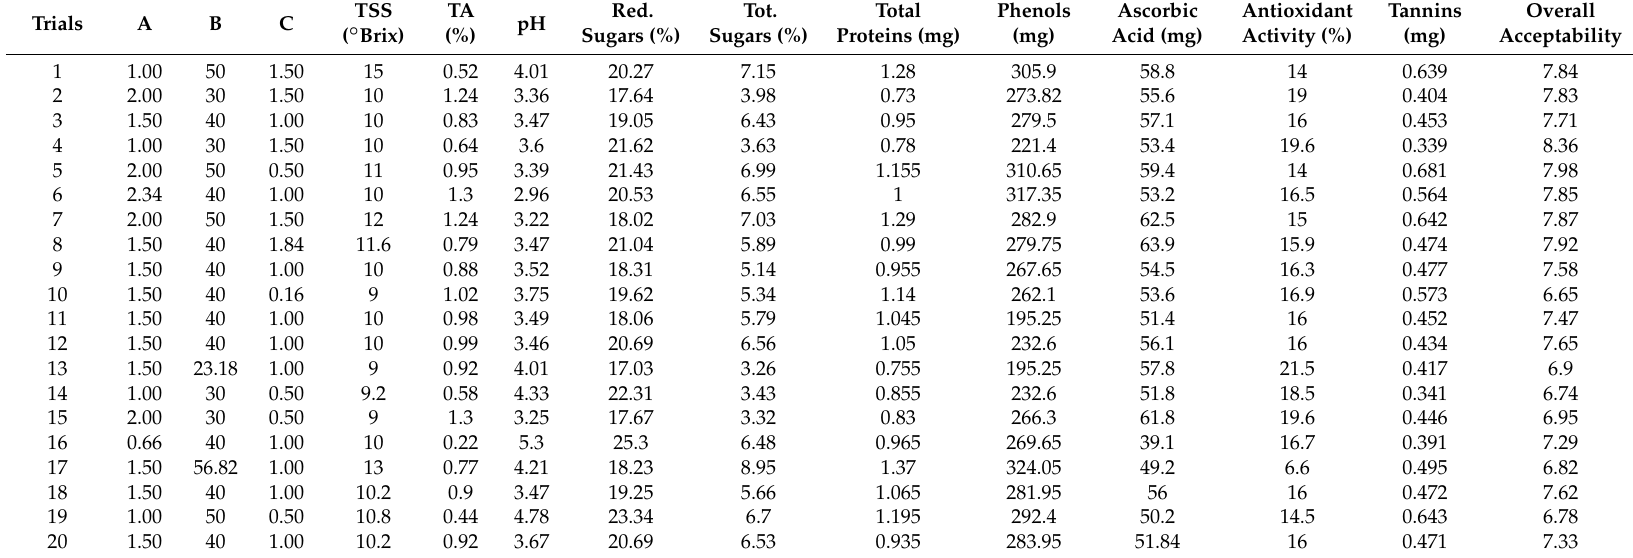
Table 1. Treatment combinations along with their responses obtained during the preparation of blended cucumber